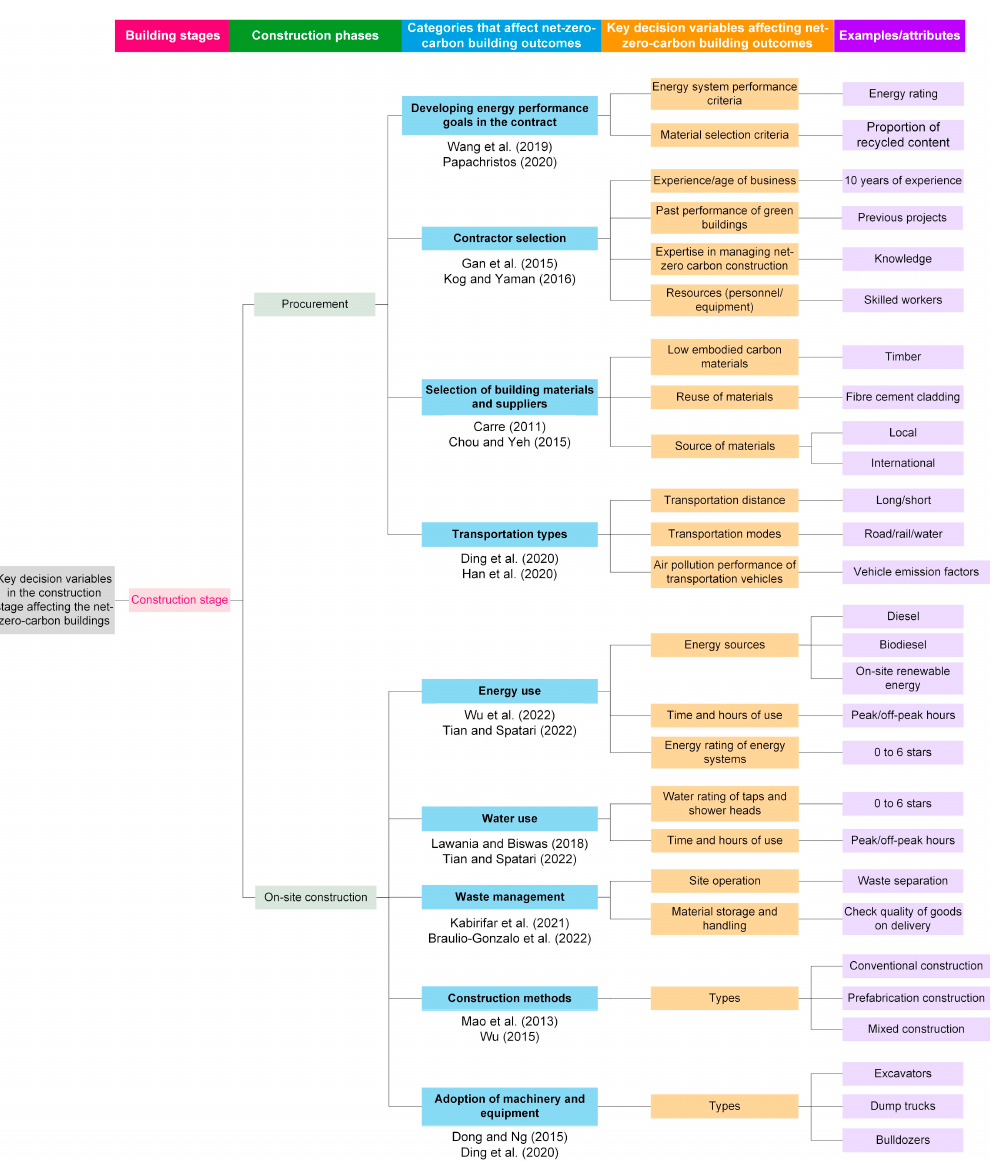
Figure 5. Summary of categories and key decision variables which affect net-zero-carbon building Figure outcomes at construction stage (key relevant references are provided to each category) [35,80,81,83– 85,87–89,91,92,95,97,99,100].